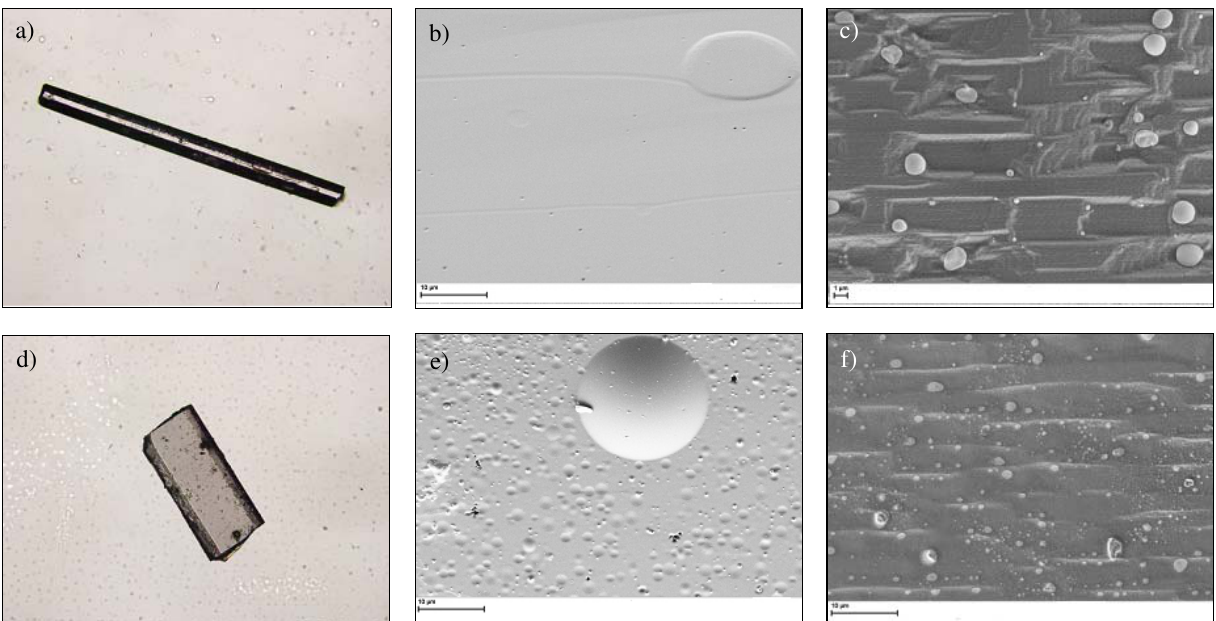
Figure 3: Microphotographs and SEM images obtained on rod-shaped crystals (a–c) and plate-like crystals (d–f) showing their shape (a and d) and close-up images which show the surface topography before (b,e) and after (c,f) the exposure to the dissolution medium at final time point 5